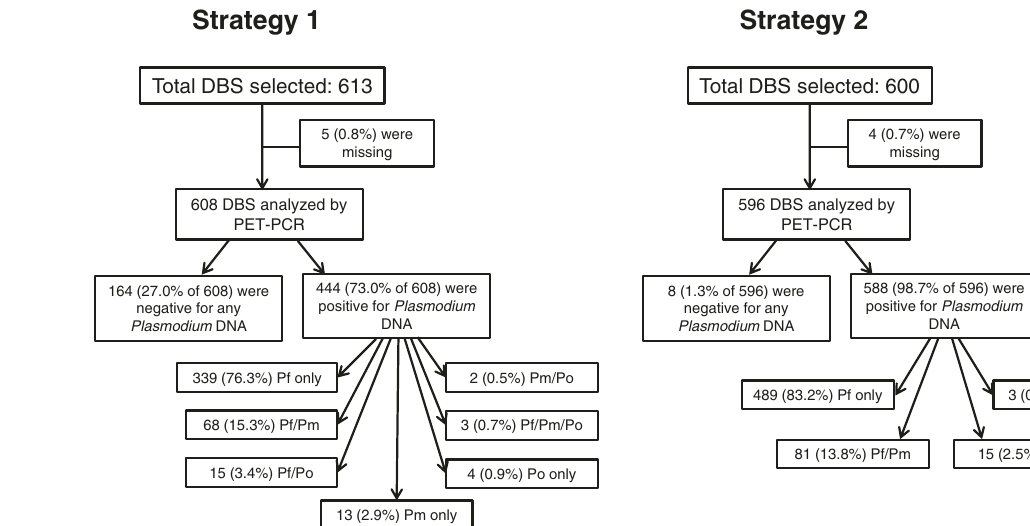
Table 2 | Crude and adjusted odds ratio estimates for PCR-con fi rmed P. malariae or P. ovale infections compared to no Plasmodium infection with adjusted estimates considering demographic, socioeconomic, and behavioral risk factors P. malariae P.